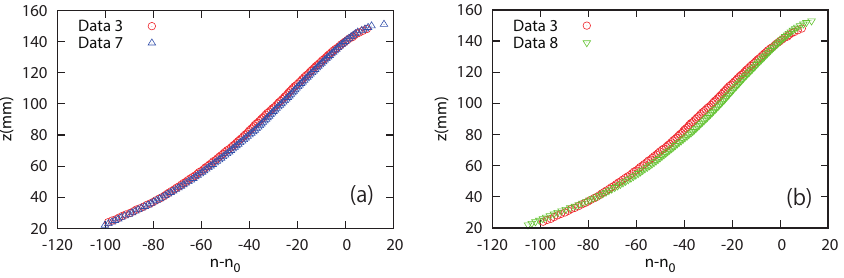
Figure 4. Rising motion obtained in the up-down case at f = 30 Hz and a = 70 m / s 2 . (a) Upwards sawtooth (Data 7) vs. triangle (Data 3). (b) Downwards sawtooth (Data 8) vs. triangle (Data 3).